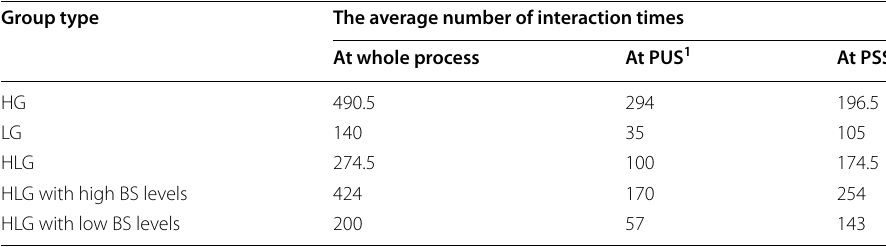
1 PUS: Problem‑understanding stage 2 PSS: Problem‑solving stage